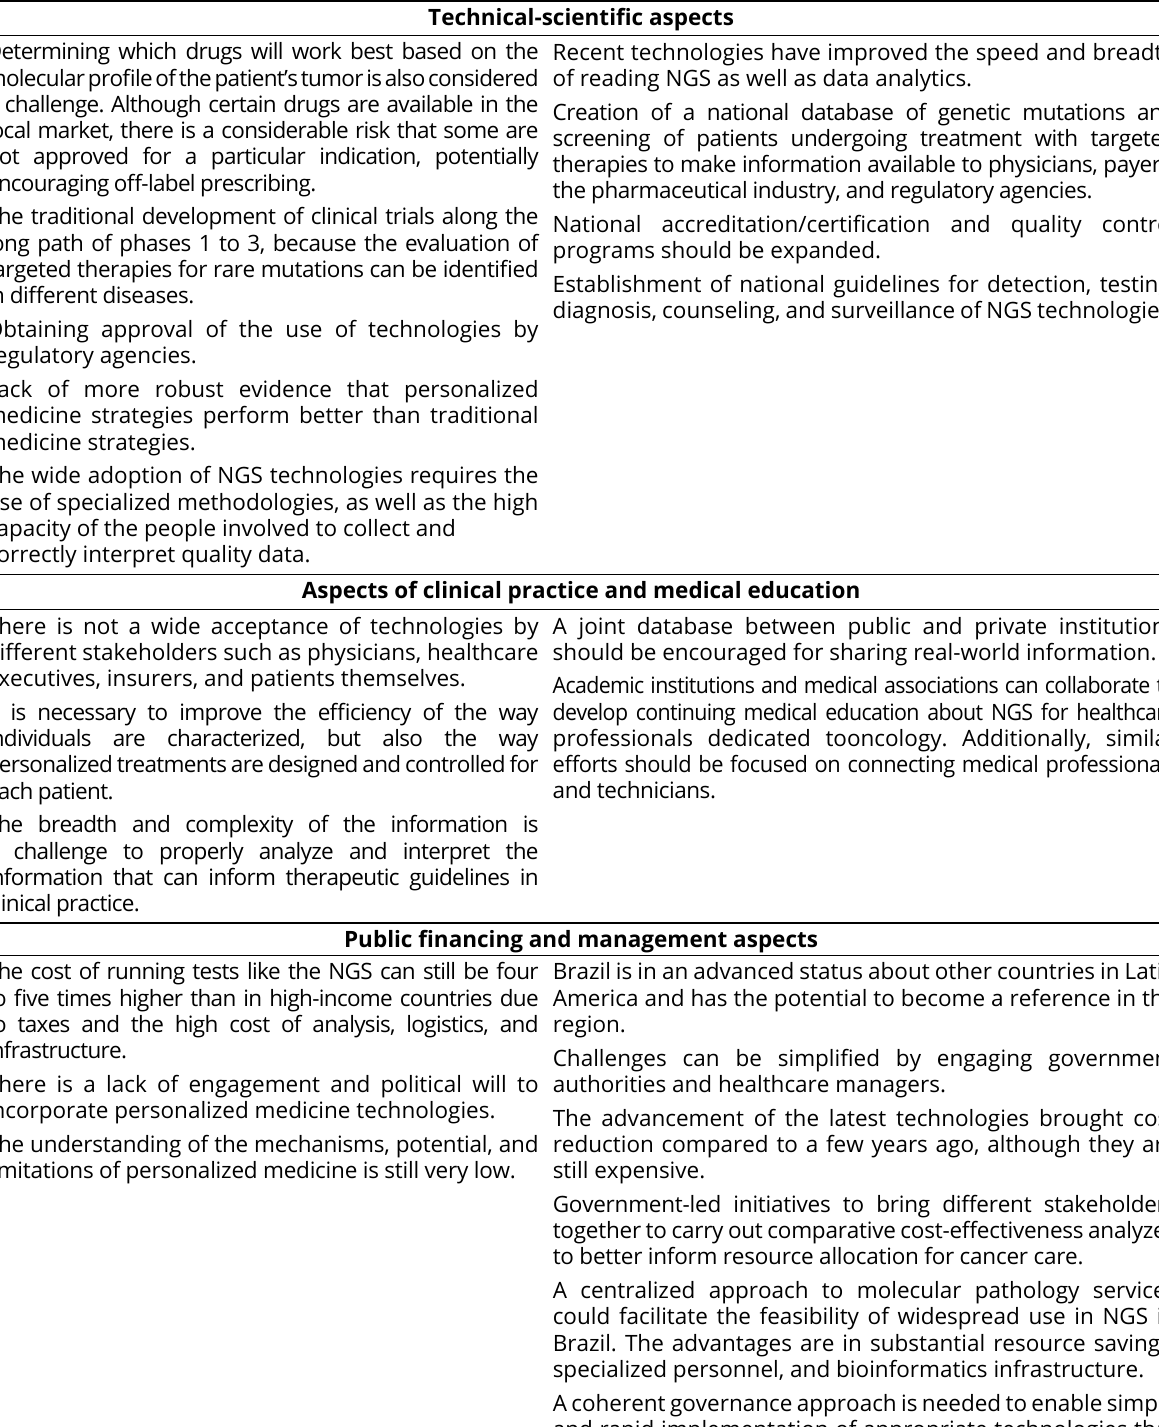
Table 2. Matrix of challenges and opportunities for the implementation of Personalized Medicine in the SUS. Challenges